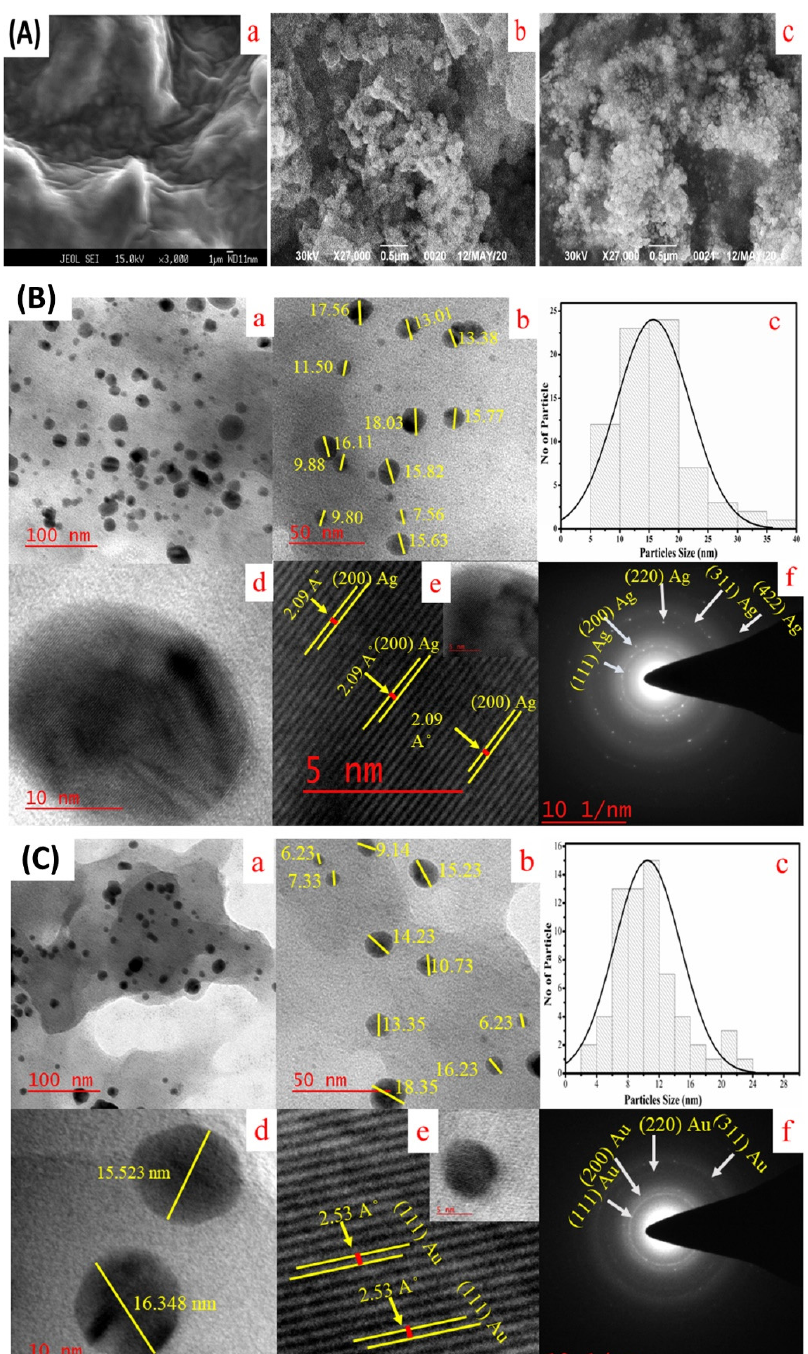
Figure 5. ( A ) SEM images of Ag NPs and Au NPs synthesized from aqueous extract of oyster mushroom P. sajor-caju . ( a ) Aqueous extract of oyster mushroom P. sajor-caju ; ( b ) P. sajor-caju mediated synthesized Ag NPs and ( c ) Au NPs. ( B ) TEM images and size distribution histogram of biosynthesized Ag NPs ( a to f ) in which the scale bar represents at 100 nm ( a ), 50 nm ( b ), particle size histogram analysis of Ag NPs ( c ), 10 nm ( d ), and at 5 nm high-resolution TEM (HR-TEM) image of a single Ag NPs respectively with lattice fringes ( e ) and SAED pattern ( f ).; ( C ) TEM images and size distribution histogram of biosynthesized Au NPs ( a to f ) at 100 nm ( a ), at 50 nm ( b ), particle size histogram analysis of Au NPs ( c ), at 10 nm ( d ), at 5 nm HR-TEM image of an Au NPs respectively with lattice fringes ( e ) and SAED pattern ( f ).